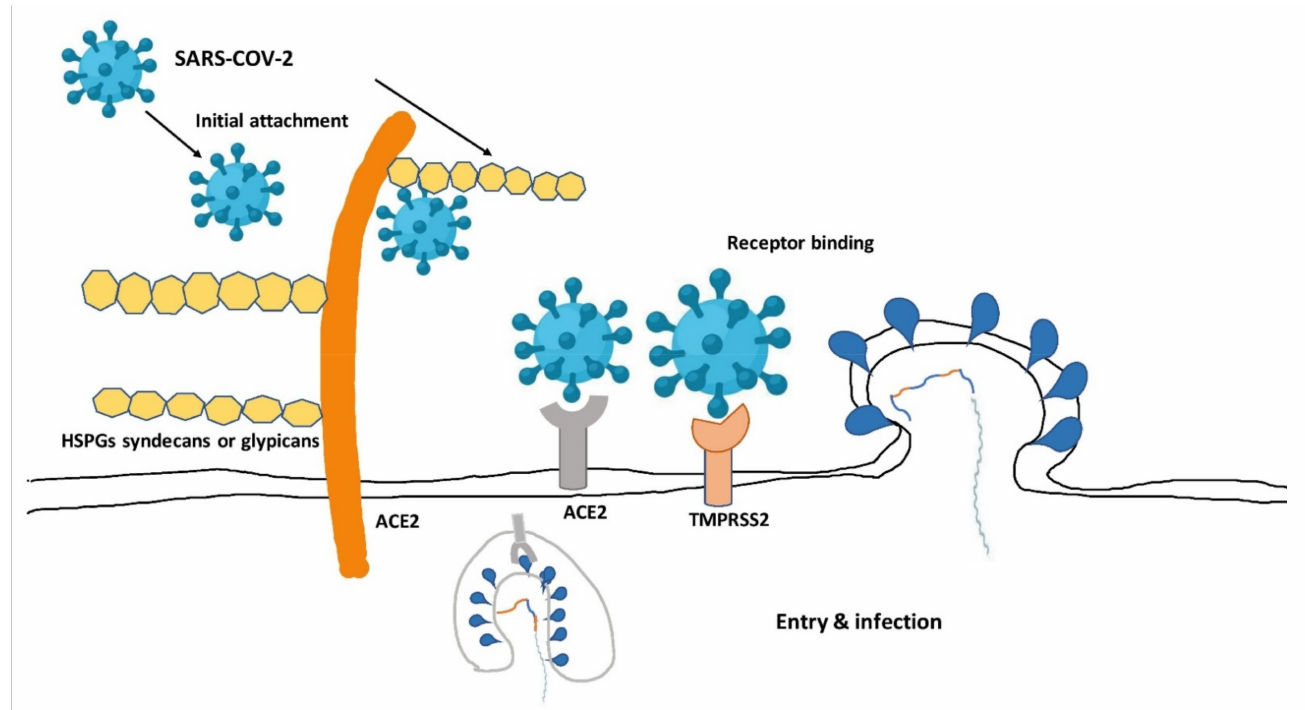
Figure 1. SARS-CoV-2 infection and entrance via a plausible pathway. Using the S protein projecting from the viral particle, SARS-CoV-2 may first engage with the HSPGs on the surface of susceptible cells early in the infection cycle. The virus’s subsequent interaction with the high-affinity entry receptor ACE2 may be facilitated by this initial attachment. By cleaving the S protein at the S1/S2 and/or S2’ sites, the transmembrane protease serine 2 (TMPRSS2) on the host cell surface and other host cell proteases may facilitate viral entry [53]. Adapted with permission from ref. [53]. Copyright 2021 Science China